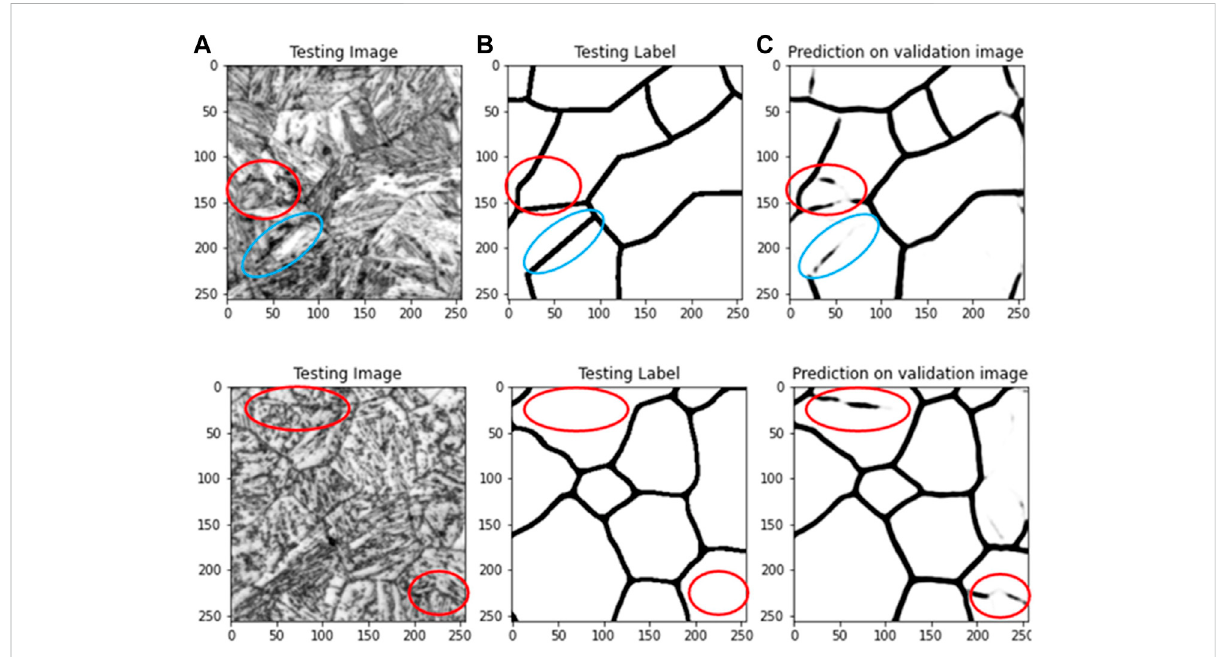
FIGURE 4 Representative patches of LOM micrographs (upper: martensitic, lower: bainitic) from unseen validation dataset (A) , the corresponding ground truthlabel (B) andthepredictionofthe fi nalmodelbeforepost-processing (C) .Duetothesoftmaxfunction,appliedtotheoutput,thesegmentation result is a greyscale image, representing the predicted probability of the respective